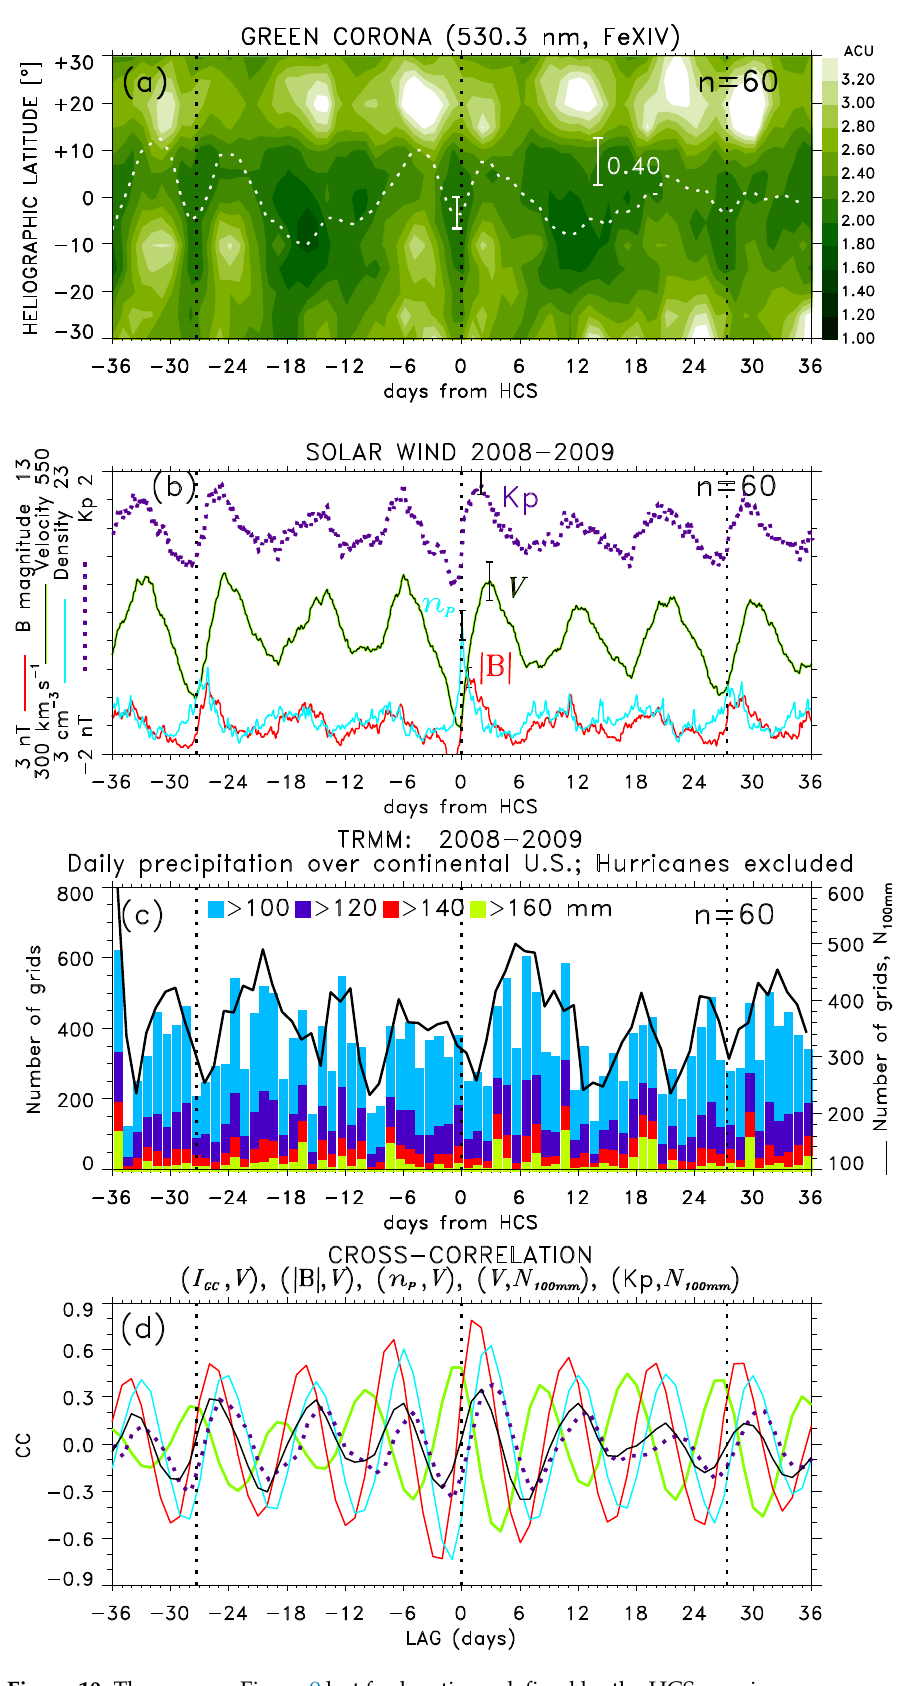
Figure 10. The same as Figure 9 but for key times defined by the HCS crossings.